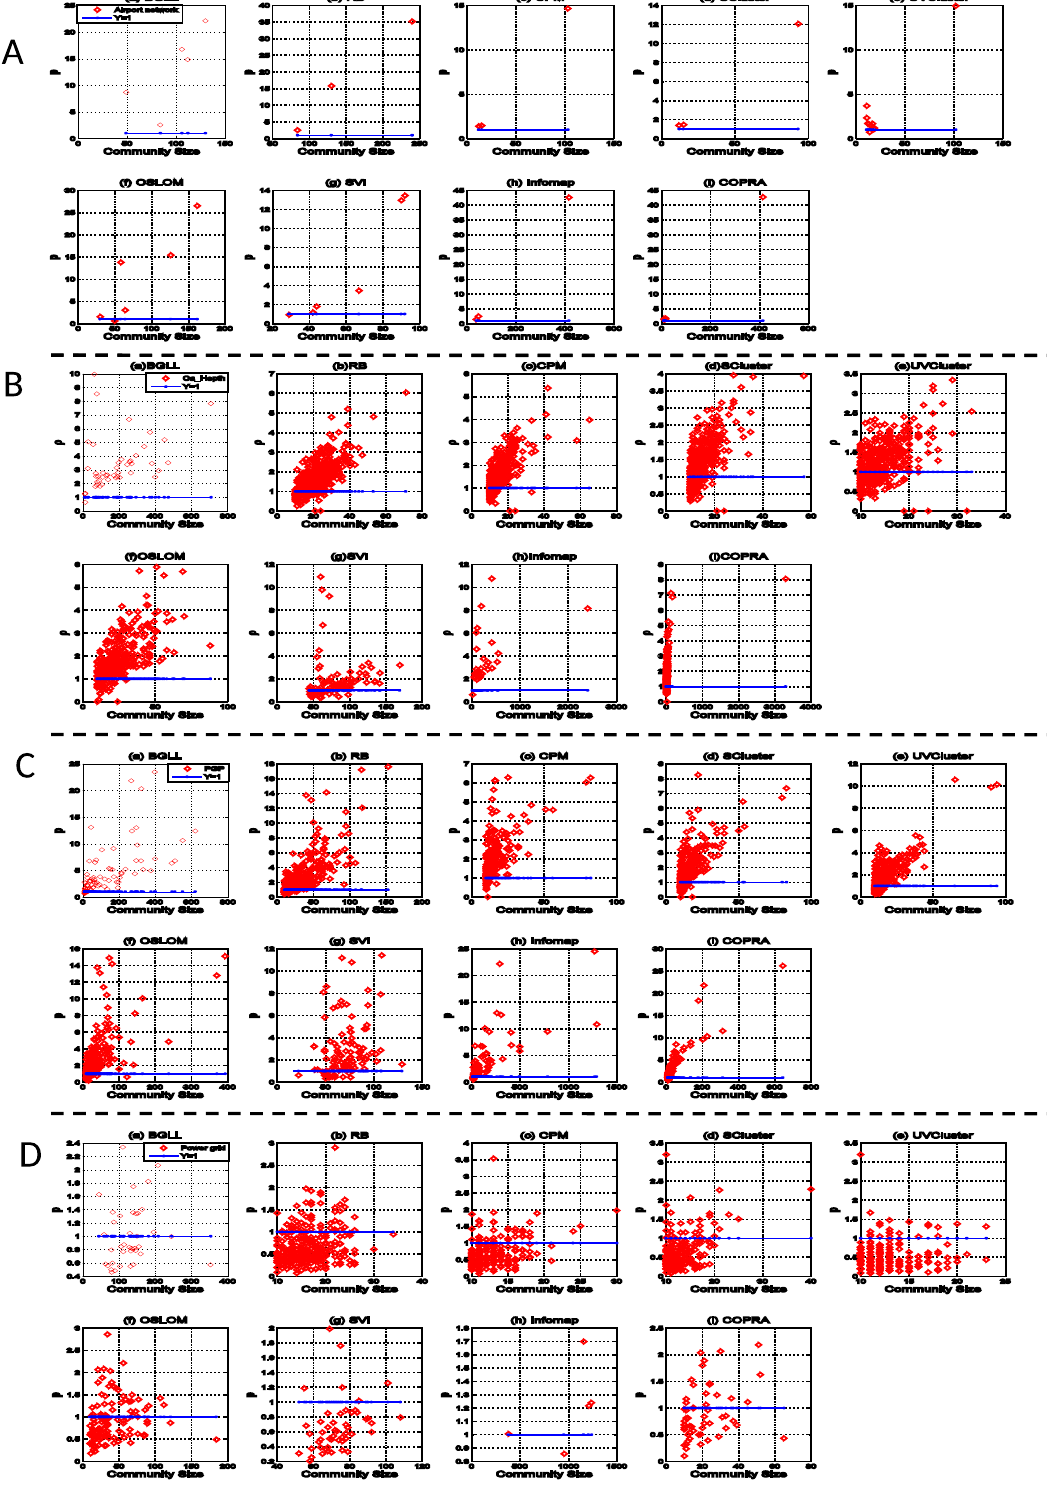
Figure 4. Variance ratios ρ of communities in ( A ) the US airport network, ( B ) Ca_Hepth citation network, ( C ) PGP network and ( D ) Power grid network that were discovered by 9 community-finding methods. Each figure for one of the four networks represents the result from one of the nine community-finding methods. For clarity, the x-axes correspond to community sizies, which are ordered from small to large. ( A ) In the US airport network, all of the communities, except four, have variance ratios ρ > 0, so that they were marked as leader communities. ( B and C ) In the Ca_Hepth citation network and the PGP networks, more leader communities were detected by the nine methods. ( D ) In the Power grid network, more self-organizing than leader communities were identified by eight of the nine algorithms, with Infomap as an